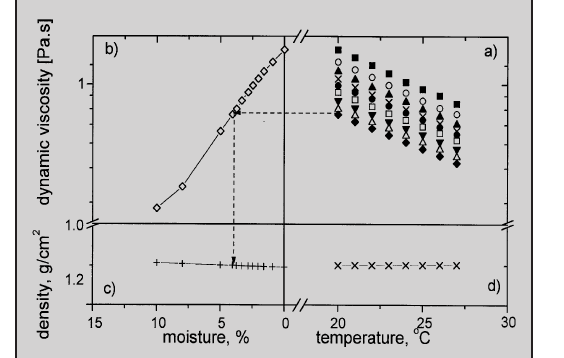
Figure 4 (left): Relationships between viscosity, temperature, moisture content and density of the model fluid: a) flow curves depending on tempreature and moisture content; b) viscosity dependence on moisture content (T=20 ° C); c) density dependence on moisture content; d) density dependence on temperature. Figure 5 (right): Results from measured discharges without (open symbols) and with (full symbols) correction for temperature and moisture content of the model fluid (drainage pipe distance 10